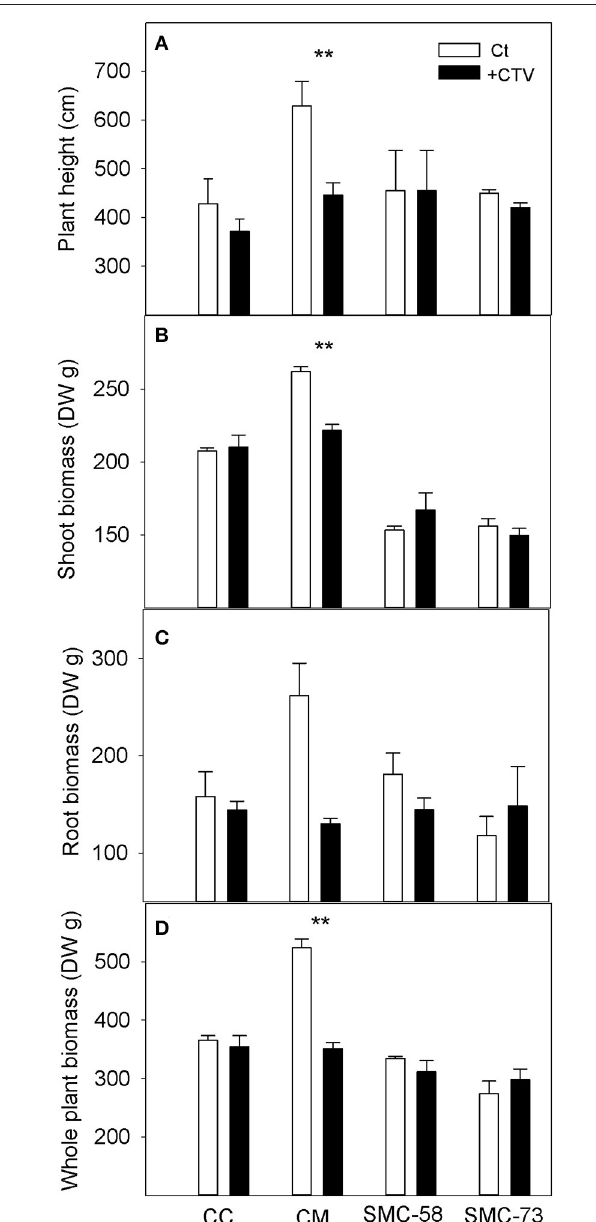
FIGURE 7 | Influence of Citrus tristeza virus (CTV) on Carrizo citrange (CC) , C. macrophylla (CM) and somatic hybrids SMC-58 and SMC-73 plants. (A) Plant height (cm), (B) Aerial parts plant biomass (DWg), (C) Root biomass, (D) Whole plant biomass. Plants were either inoculated with the T388 strain of CTV ( + CTV) or treated as non-inoculated controls (Ct) and cultivated for 12 months under glasshouse conditions. Values are the mean between 3 and 6 plants and standard error. **Significant differences for P ≤ 0.01 on Duncan’s multiple range test.